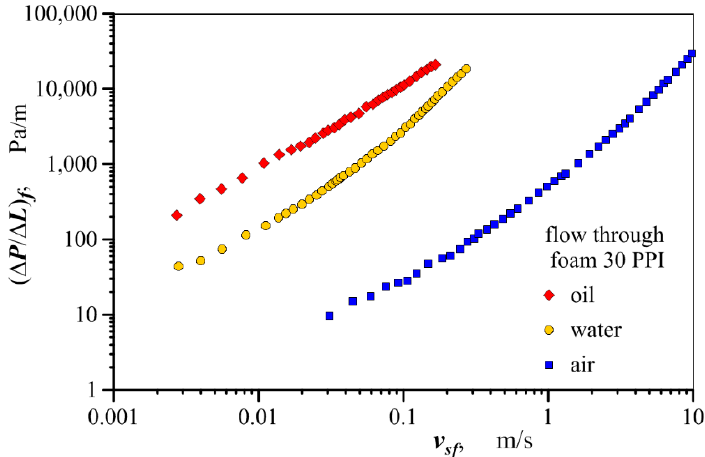
Figure 7. Measured pressure drop comparison for air, water and oil flowing through 30 PPI foam.